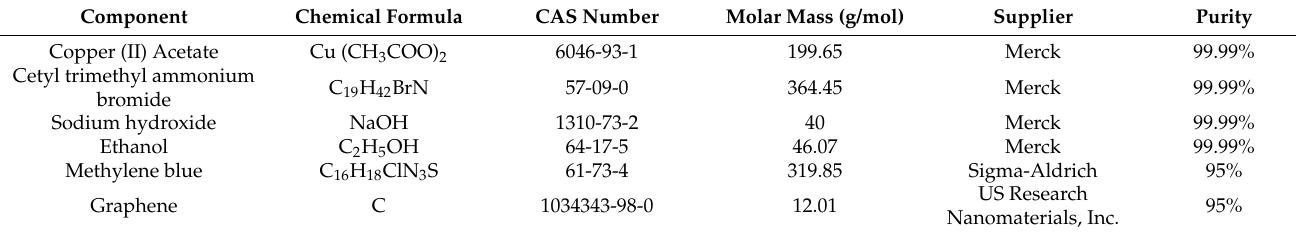
Table 1. Chemical information of starting